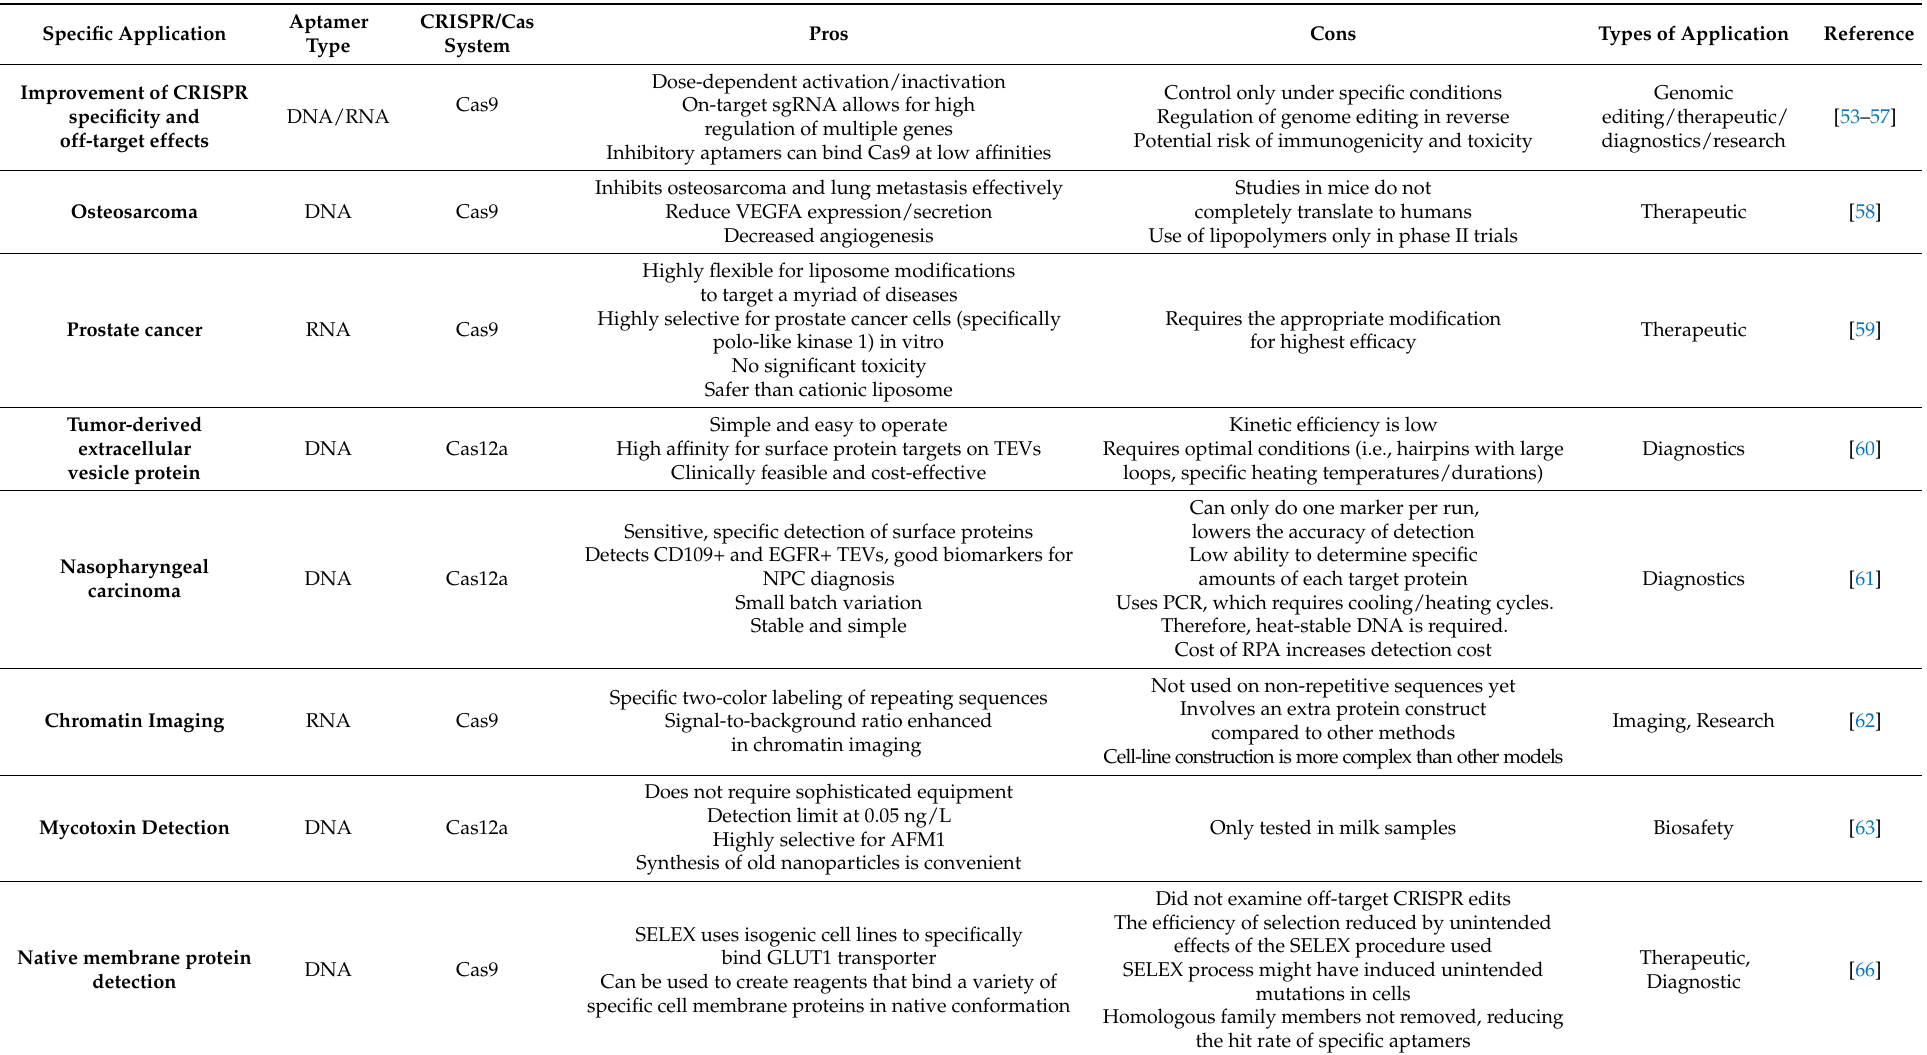
Table 1. Summary of aptamer–CRISPR areas of